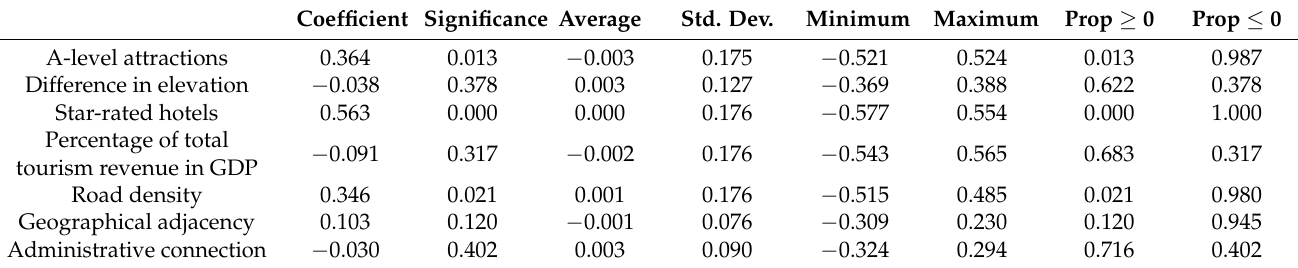
Table 5. QAP correlation